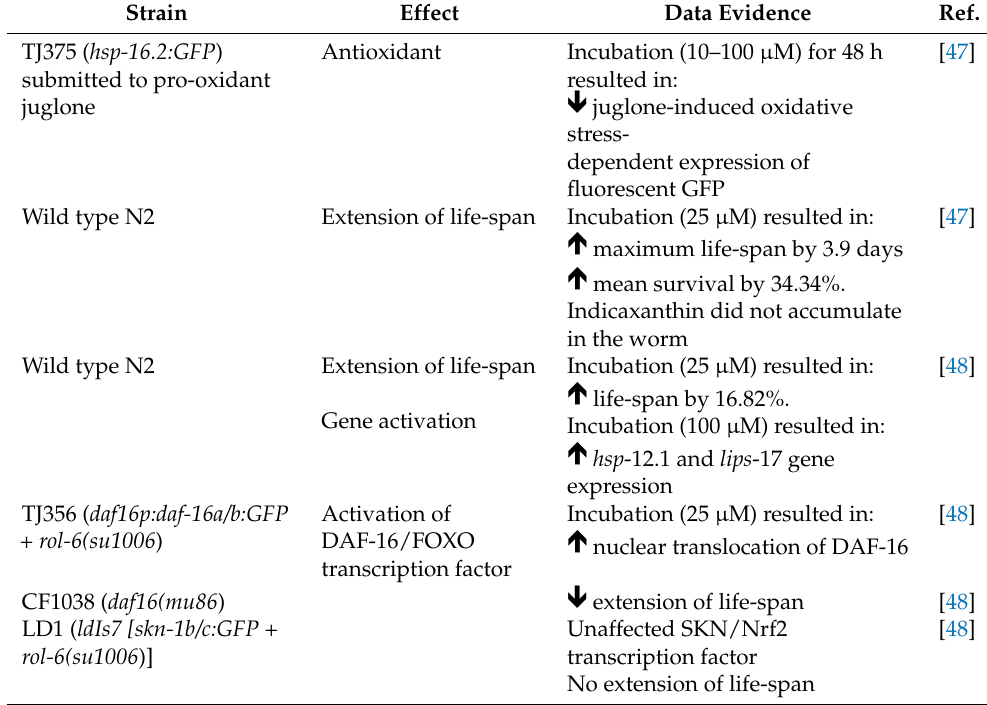
Table 5. Activity of Indicaxanthin in C. elegans . Table 6. Activity of Indicaxanthin in murine models.